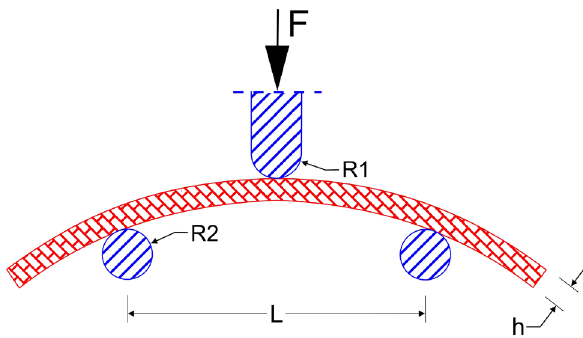
Figure 1: Three-point bending – test